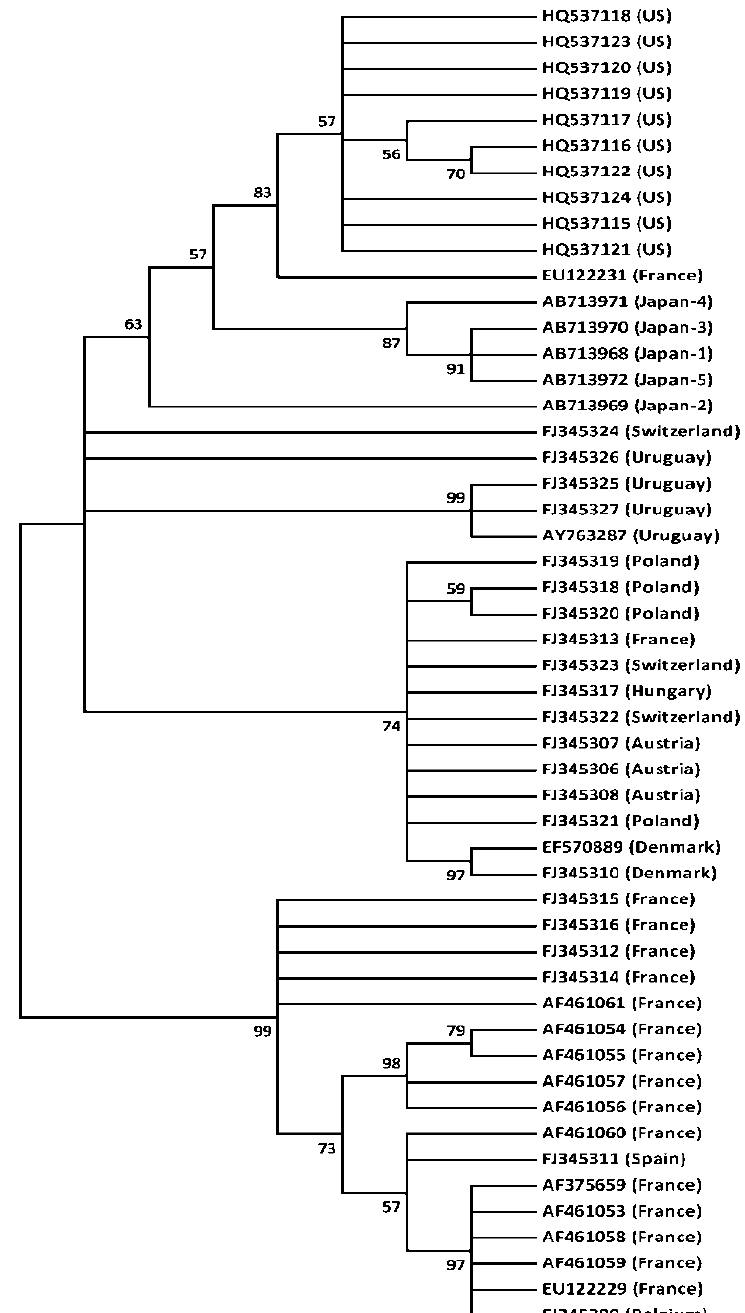
Figure 2. Phylogeny of Japanese, European, Uruguayan, and mainland US CBPV isolates. The condensed phylogenetic tree (bootstrap values <50%) based on alignment of the putative RdRP gene sequences of Japanese, European, Uruguayan, and mainland US CBPV isolates was constructed using the maximum likelihood method. The number of each node represents the bootstrap value resulting from 1000 replicates. Each isolate is indicated by its accession